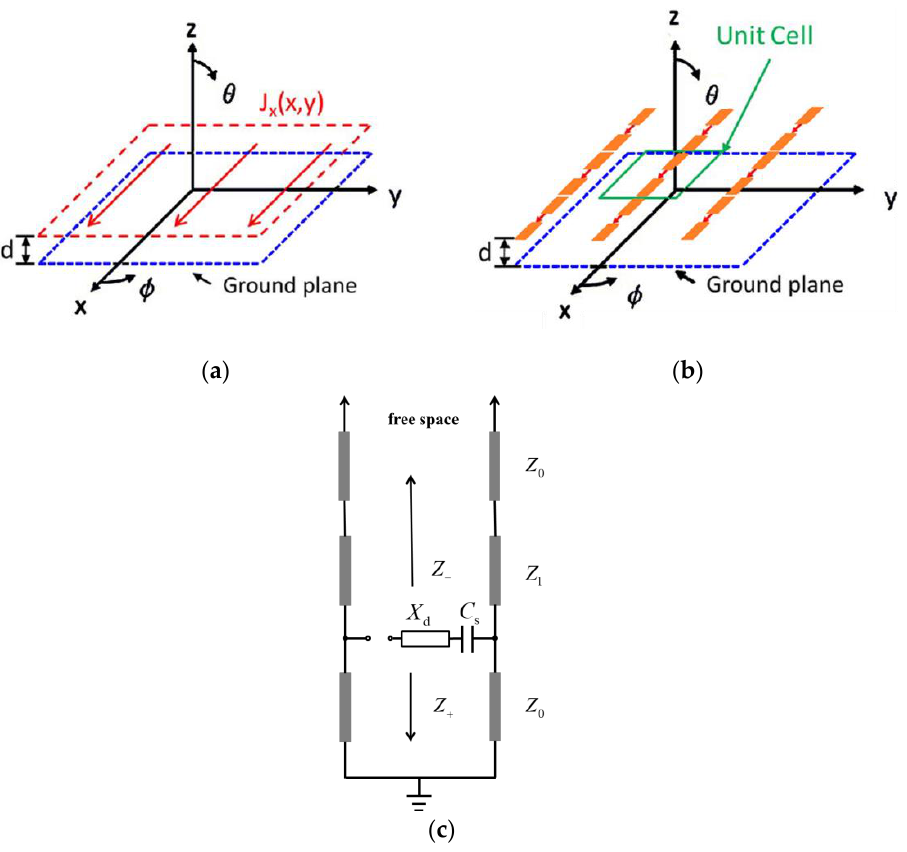
Figure 1. ( a ) Infinite current sheet array over a ground plane; ( b ) tightly coupled dipole array implementation; ( c ) Equivalent circuit of a TCDA unit cell.